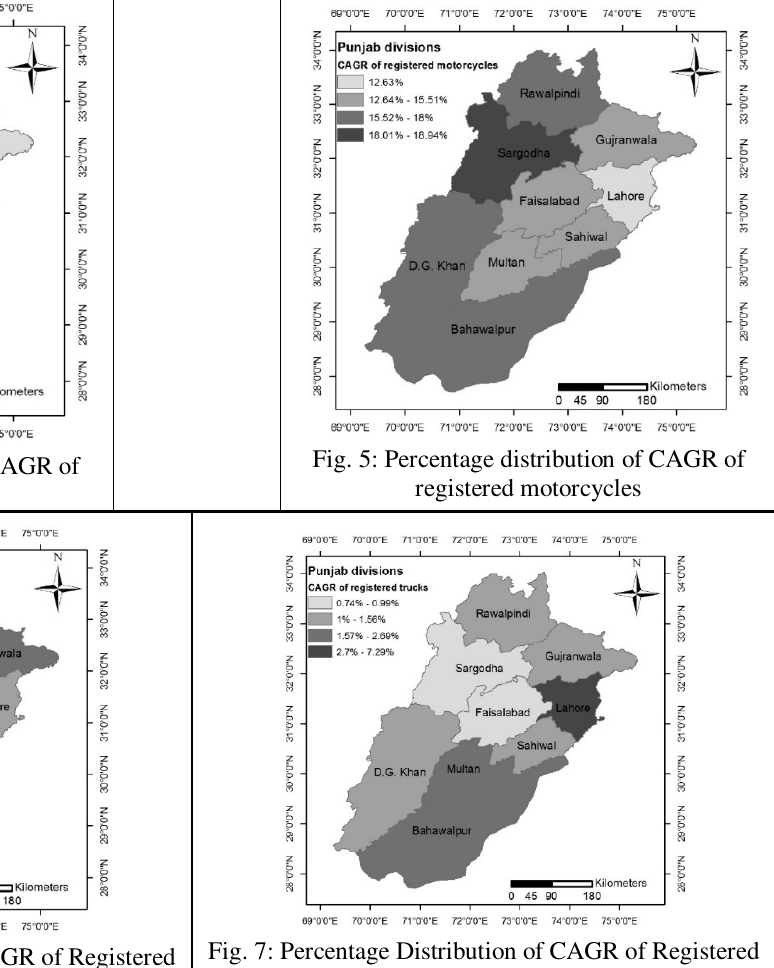
Fig. 7: Percentage Distribution of CAGR of Registered Trucks